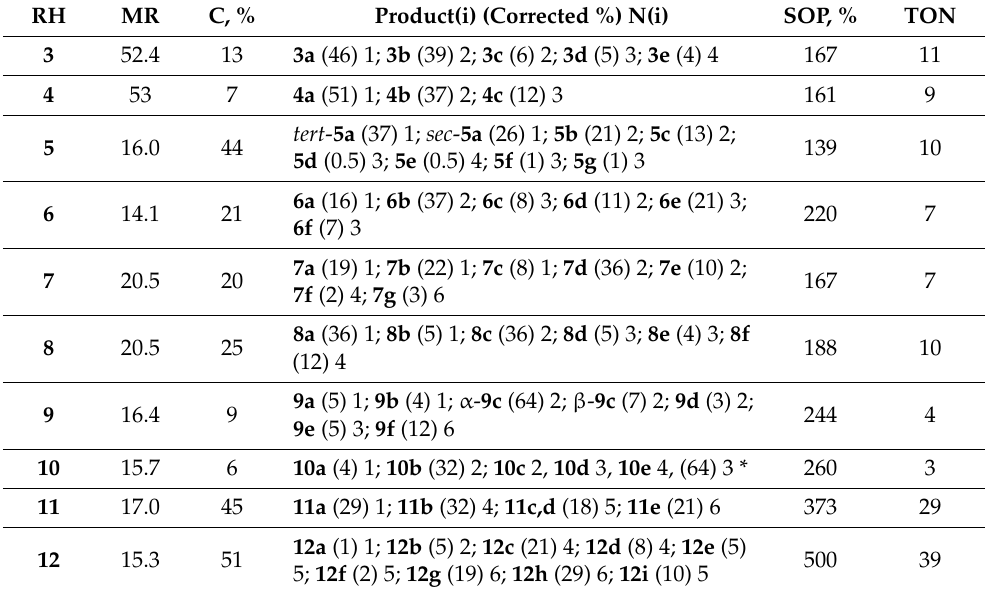
Table 1. The TON of the hydrocarbons 3 – 12 ( RH ), calculated by formula (3).